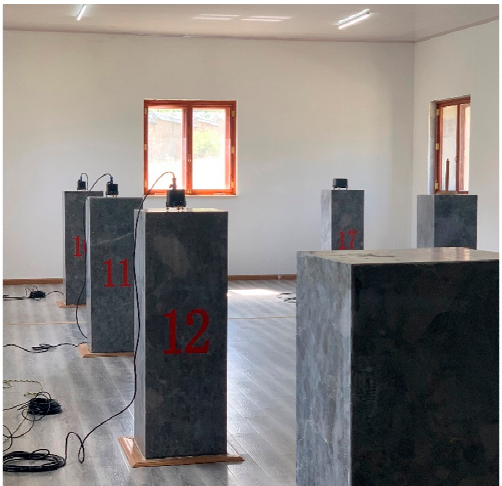
Figure 12. Photo of the observation experiment used for the fluxgate senor comparison.